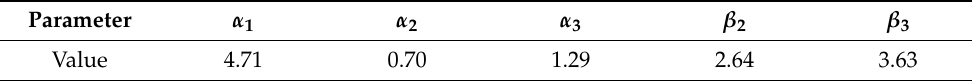
Table 2. Optimised damping parameters of the numerical model.